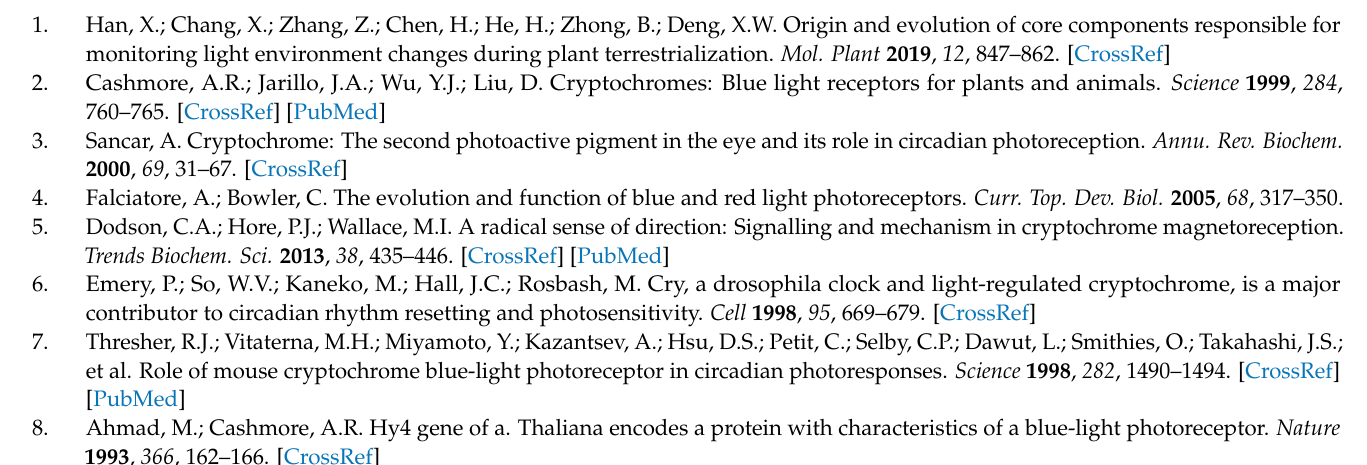
Table S1: Go enrichment. Table S2: Primers in this